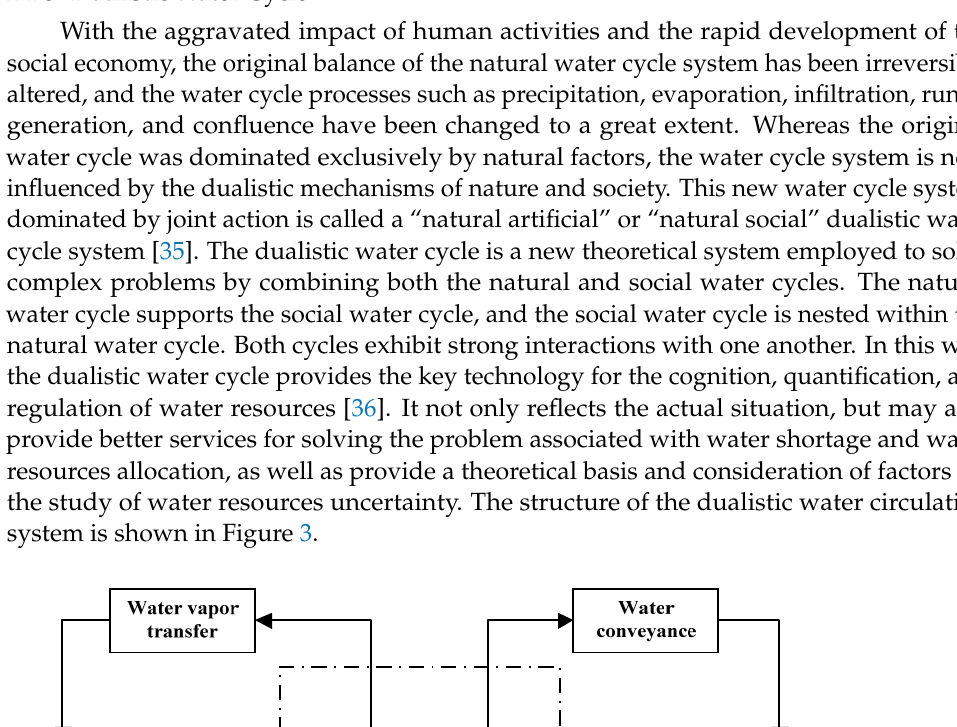
Figure 2. Schematic diagram of the social water circulation system.